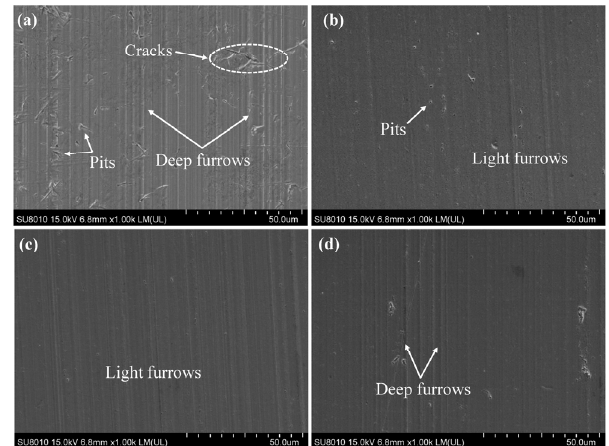
Fig. 9 SEM micrographs of the rubbed surfaces of the lower disk lubricated by PAO6 containing different mass concentrations of TiO 2 /BP nanocomposites under the load of 20 N: (a) 0%, (b) 0.005%, (c) 0.01%, and (d) 0.05%.